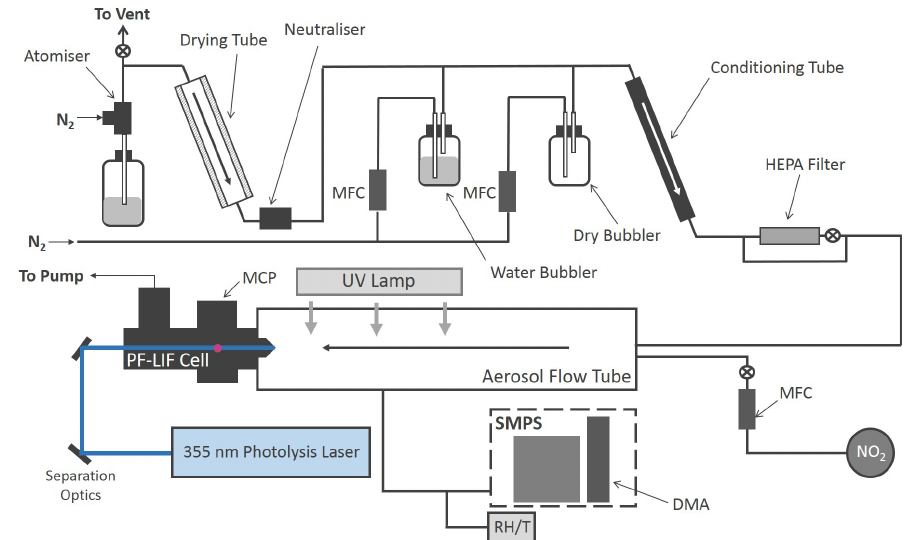
Figure 1. Schematic of the Leeds aerosol flow tube system coupled to a laser-fragmentation laser-induced fluorescence detector for HONO. The paths of the 355nm (blue) and 308nm (purple, depicted as travelling out of the page perpendicular to the 355nm light) light are also shown. CPC: condensation particle counter; DMA: differential mobility analyser; HEPA: high-efficiency particle air filter; FAGE: fluores- cence assay by gas expansion; MCP: microchannel plate photomultiplier; MFC: mass flow controller; RH/ T : relative humidity/temperature probe; SMPS: scanning mobility particle sizer.